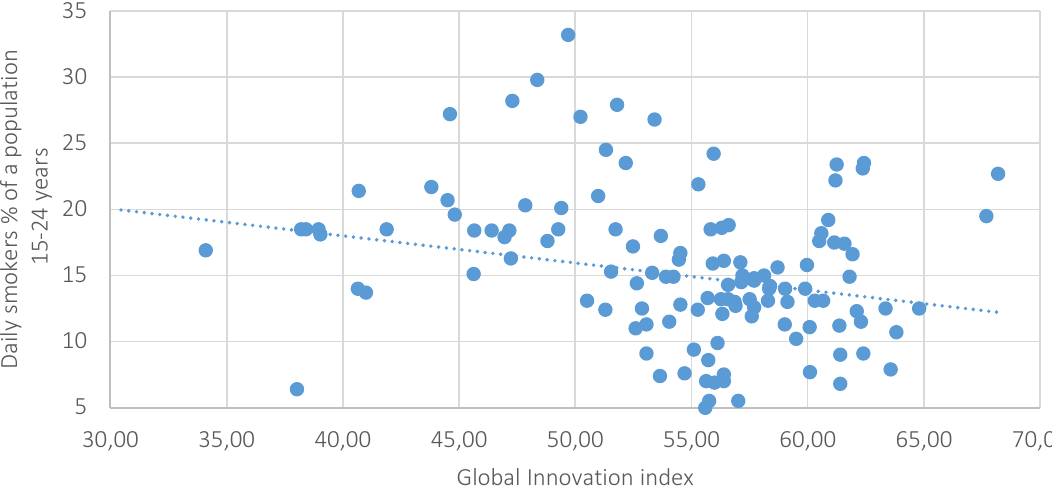
Figure 2. Relationship between GII and Smors_D%15-24